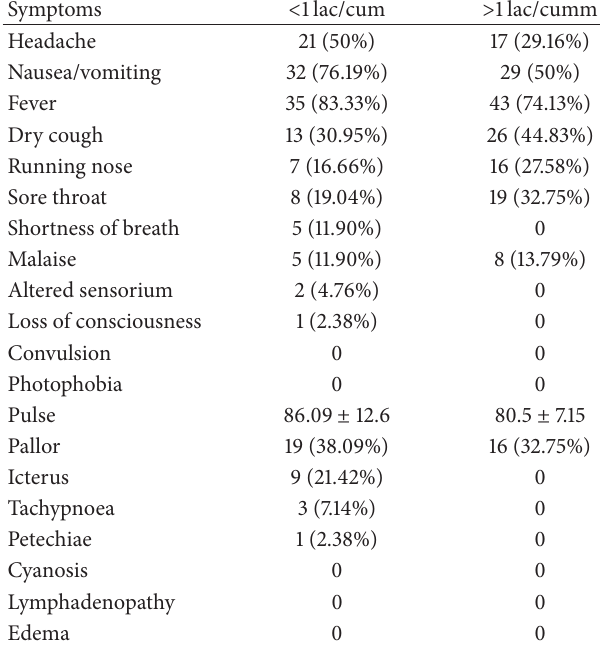
Table 1: Basic characteristics of the two groups ( < 1 lac/cumm and > 1 lac/cumm).